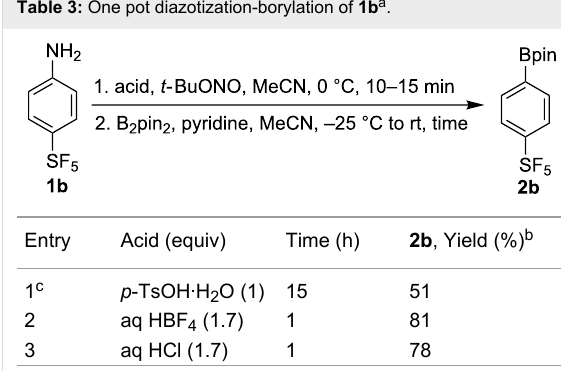
Table 3: One pot diazotization-borylation of 1b a